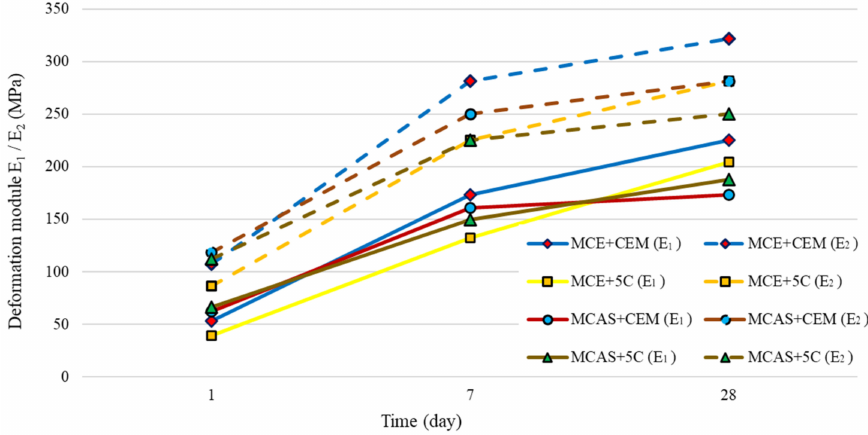
Figure 10. Results of tests of the strength of the recycled base